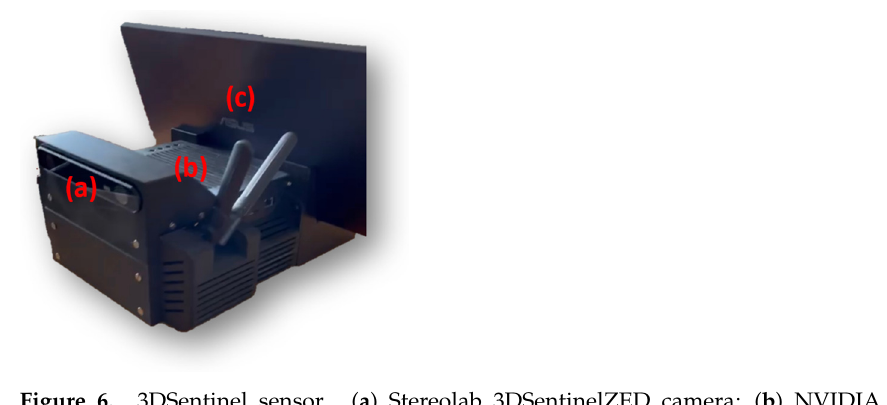
Figure 6. 3DSentinel sensor. ( a ) Stereolab 3DSentinelZED camera; ( b ) NVIDIA Xavier PC; ( c ) Removable Monitor for setting sensor parameters.